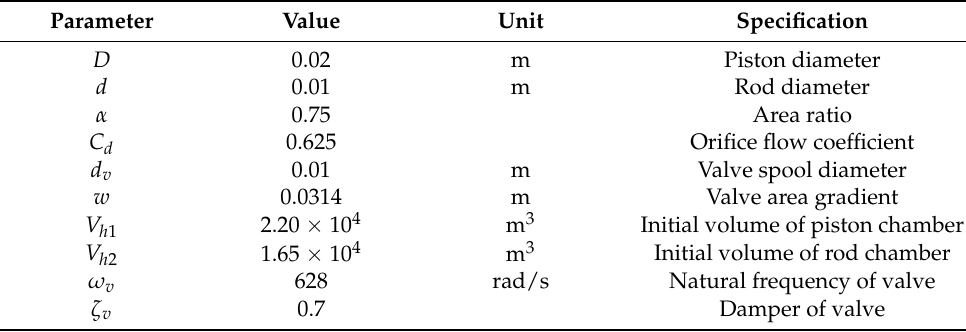
Table 3. Key parameters of the whole model